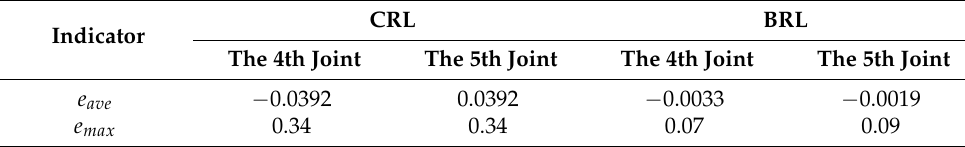
Figure 12. Experimental comparative result in group 1. Table 4. Comparison results of controller performance